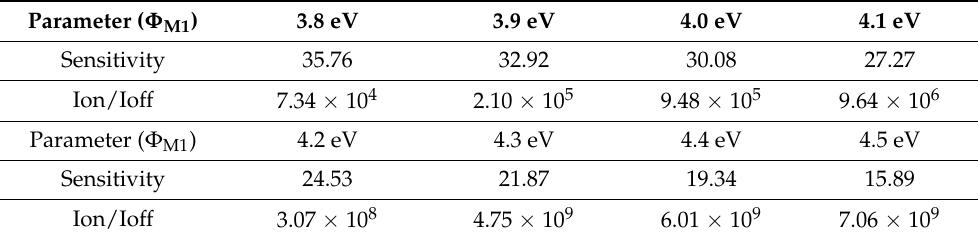
Table 2. The variation in sensitivity and switch ratios with different Φ M1 (Vgs = 2.0 V, Vds = 1.0 V, Φ Φ M2 = 3.9 eV, PG = 5.9 eV).